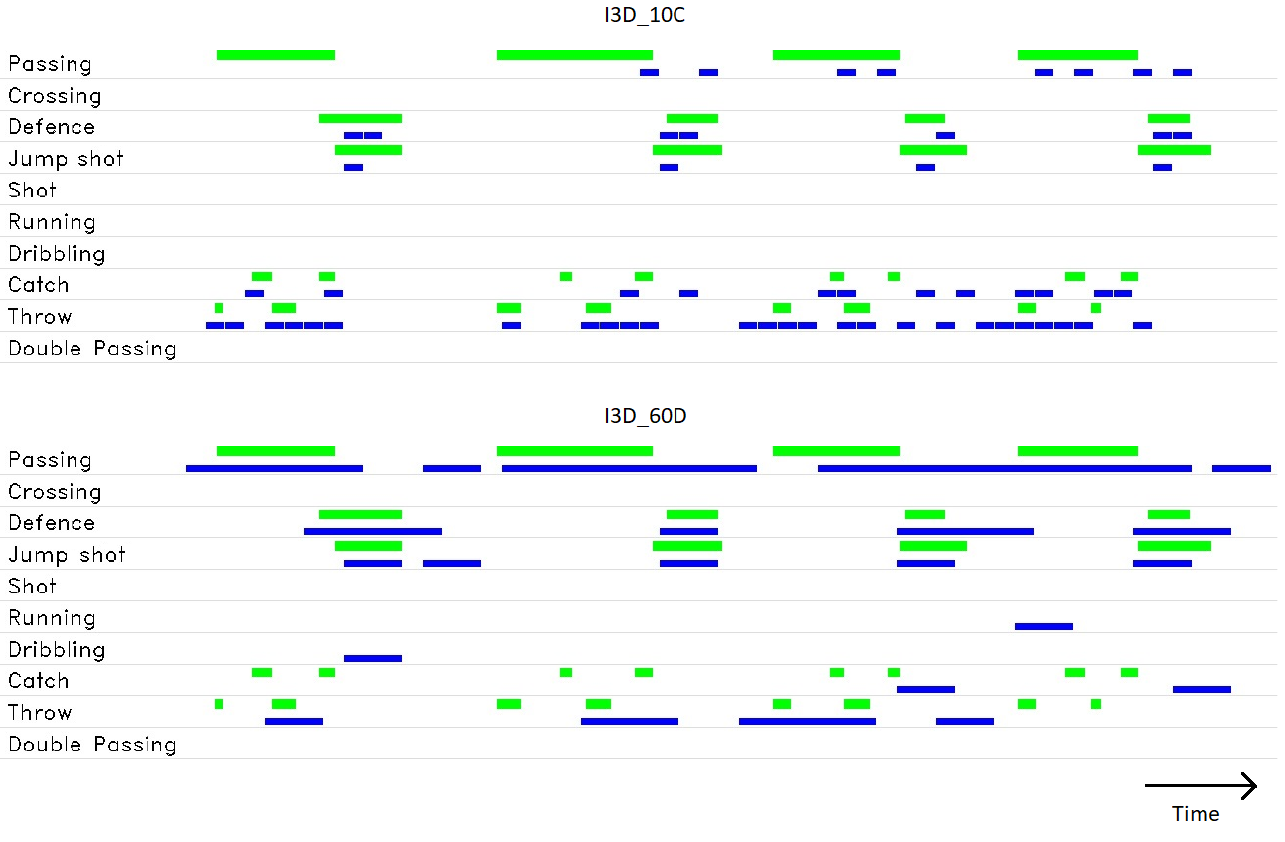
Figure 7. Visualization of temporal action localization timeline for I3D_10C ( top ) and 13D_60D ( bottom ). Green lines are ground truth action intervals, blue lines are detected action intervals.